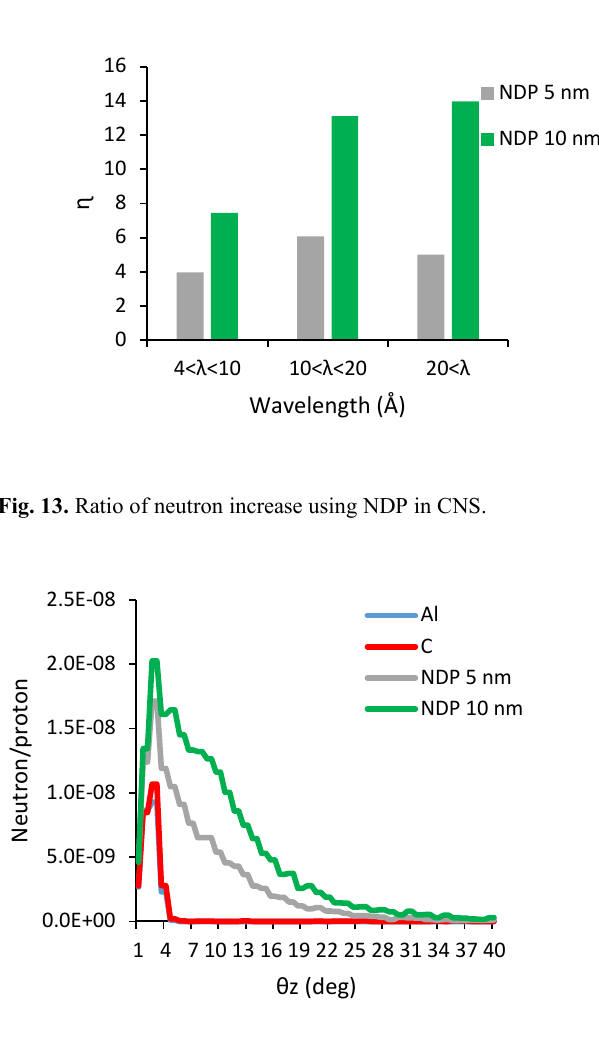
Fig. 14. CN angular distribution in CNS ( 4 Å < λ <10 Å